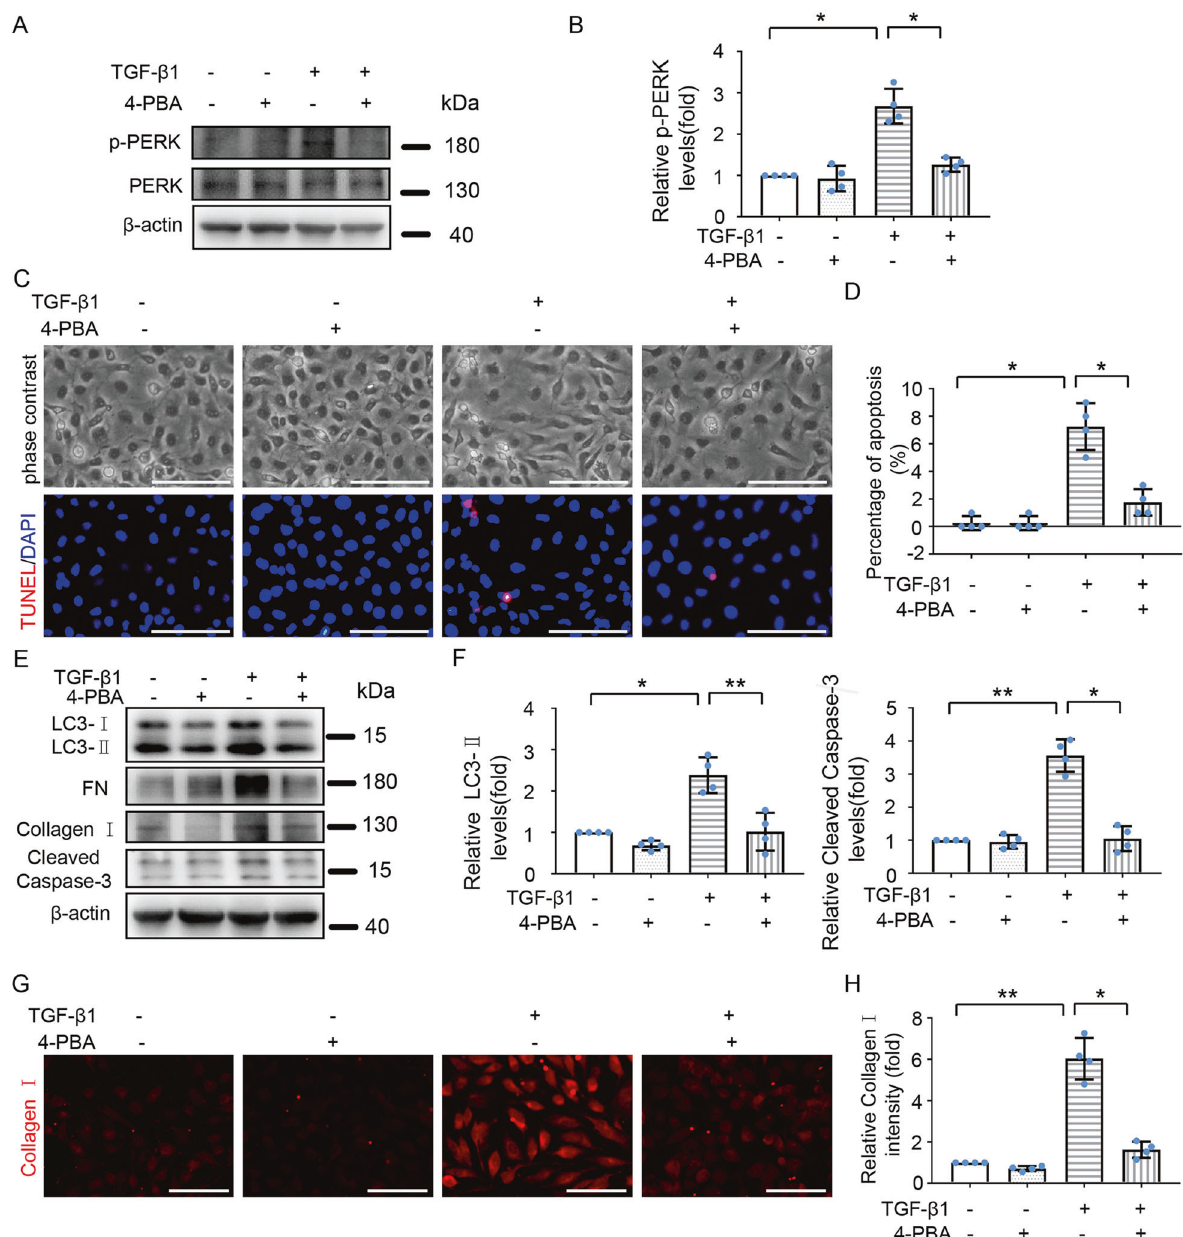
Fig. 5 Inhibition of ER stress attenuates TGF- β 1-induced autophagy, fi brosis and apoptosis in HK-2 cells. HK-2 cells were treated with or without TGF- β 1 (5 ng/ml) for 24 h in the absence or presence of 4-phenyl butyric acid (4-PBA,1 mM). A Representative immunoblot analysis of p-PERK, PERK, and β -actin. B Densitometric analysis of p-PERK band intensity. C Representative phase-contrast and TUNEL staining images. Scale bar = 100 μ m. D Counting of TUNEL staining positive cells. E Cell lysates were analyzed for LC3, FN, Collagen I, and cleaved Caspase-3 by immunoblot. F Densitometric analysis of LC3-II and cleaved caspase-3. G Representative images of Collagen I immuno fl uorescence staining. Scale bar = 100 μ m. H Quantitative analysis of Collagen I immuno fl uorescence intensity. Data are expressed as mean ± SD. n = 4. * p < 0.05, ** p <